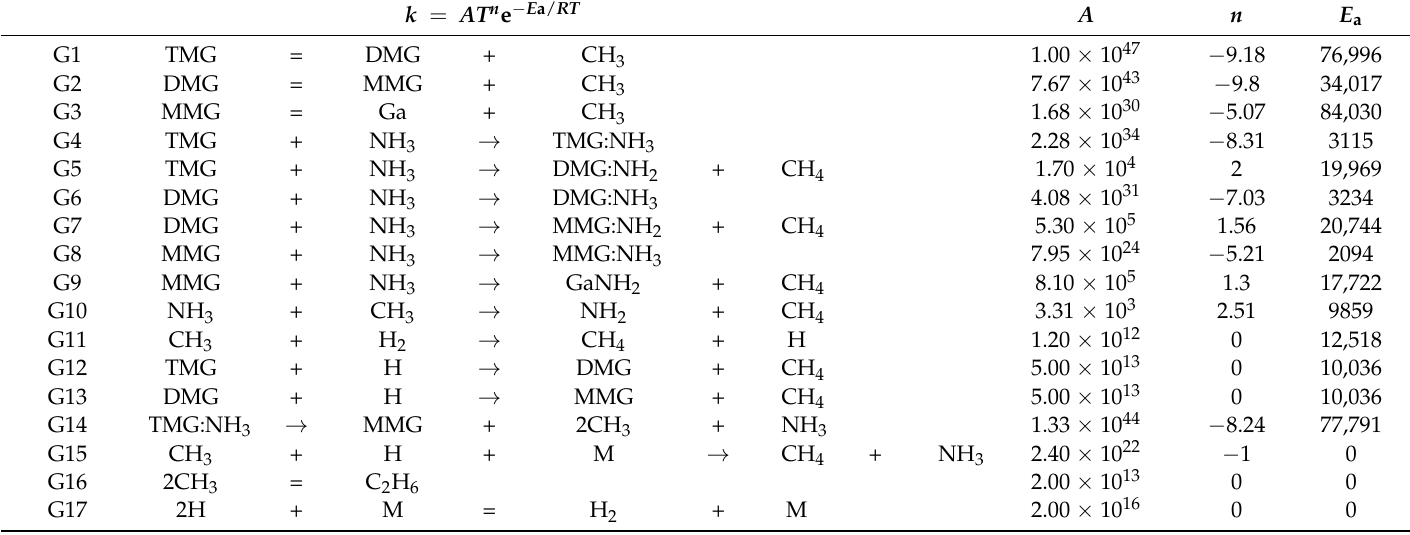
Table 1. Gas-phase mechanism for the complete model [15] (the unit of E a is Calorie). TMG, trimethyl gallium; DMG, dimethyl gallium; MMG, monomethyl